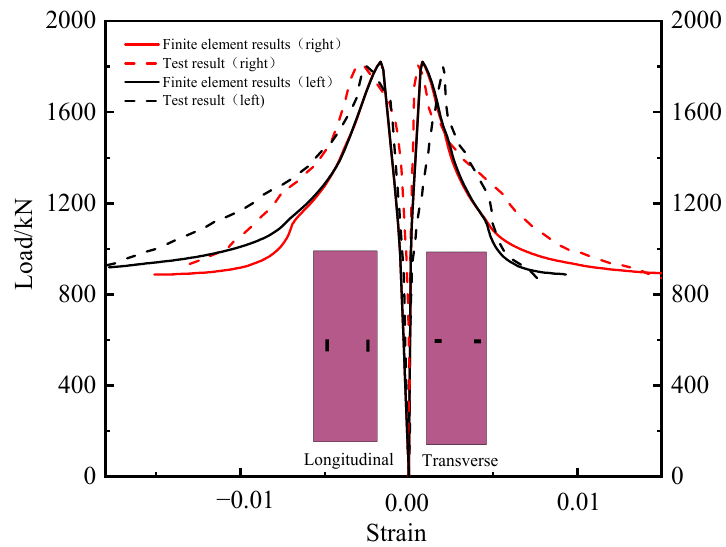
Figure 6. Load transverse strain curve and load longitudinal strain curve.